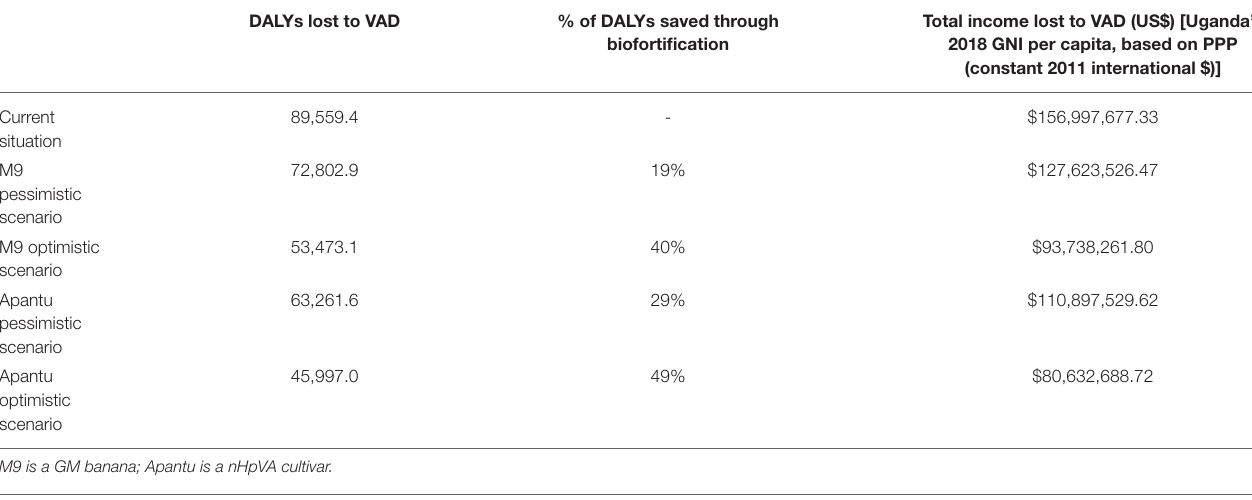
TABLE 2 | Impact of high-provitamin A cultivars in reducing Uganda’s vitamin A deficiency burden. DALYs lost to VAD